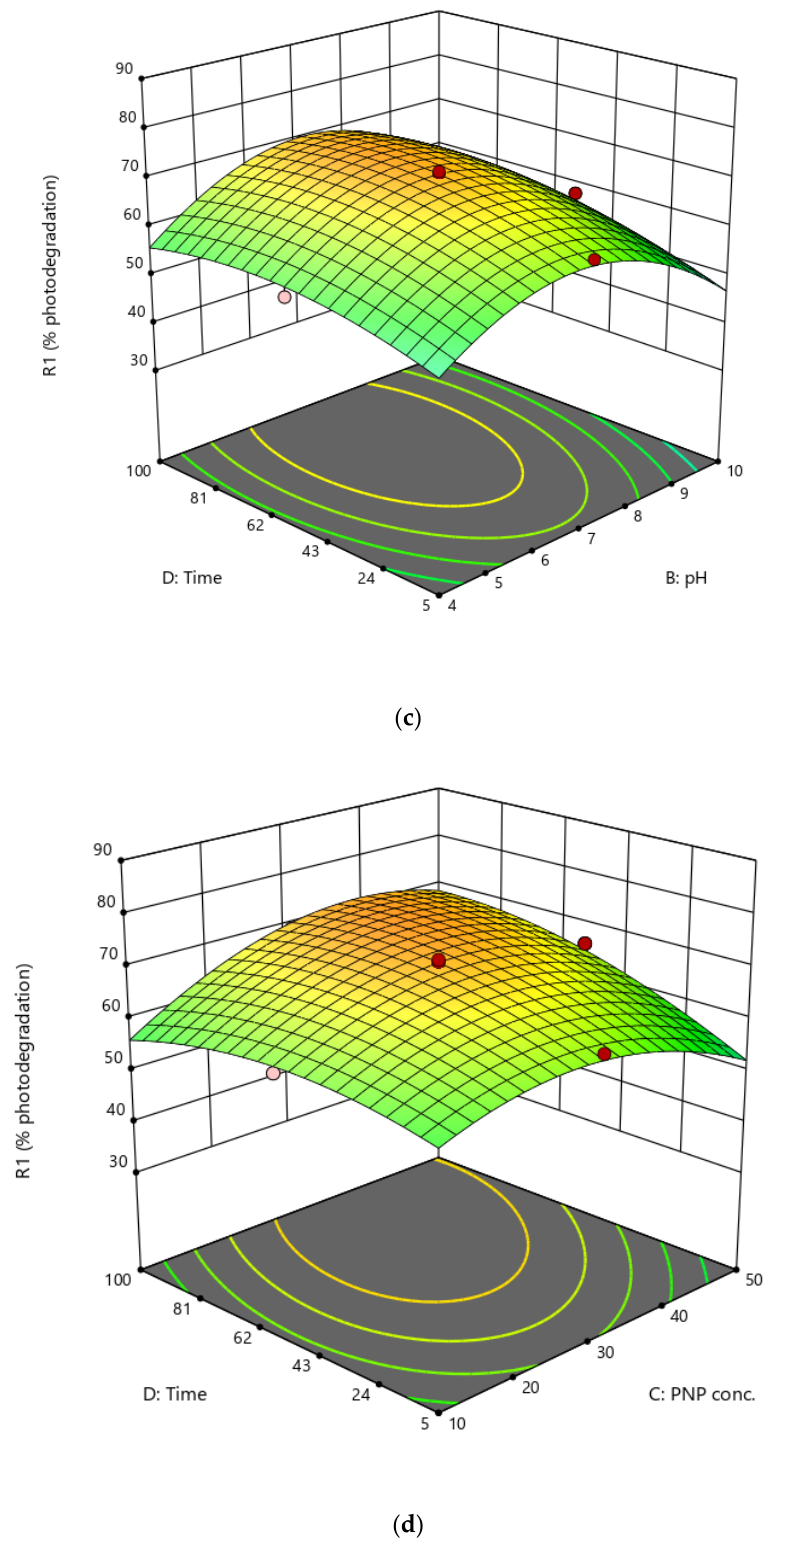
Figure 9. 3D surface plots representing the relationship between different variables ( a ) catalyst dose, time ( b ) pH, PNP conc. ( c ) pH, time ( d ) time, PNP and percentage photodegradation in case of PNP.